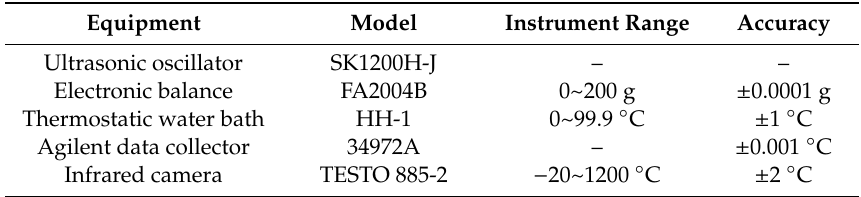
Table 1. Accuracies of